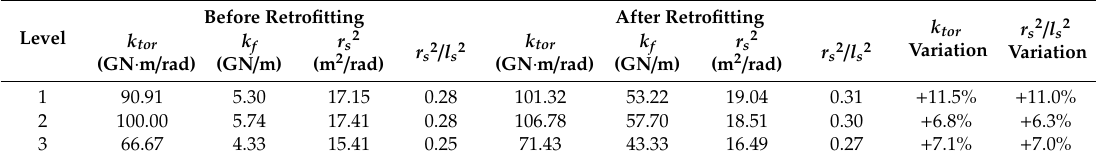
Table 2. Comparison of torsional sti ff ness and deformability of building A before and after retrofitting. Before Retrofitting After Retrofitting Level k tor